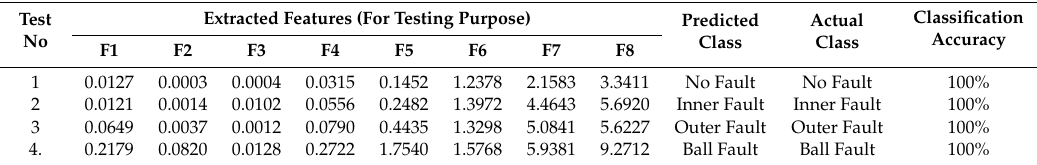
Table 7. Testing and validation of proposed approach for classification of bearing faults.